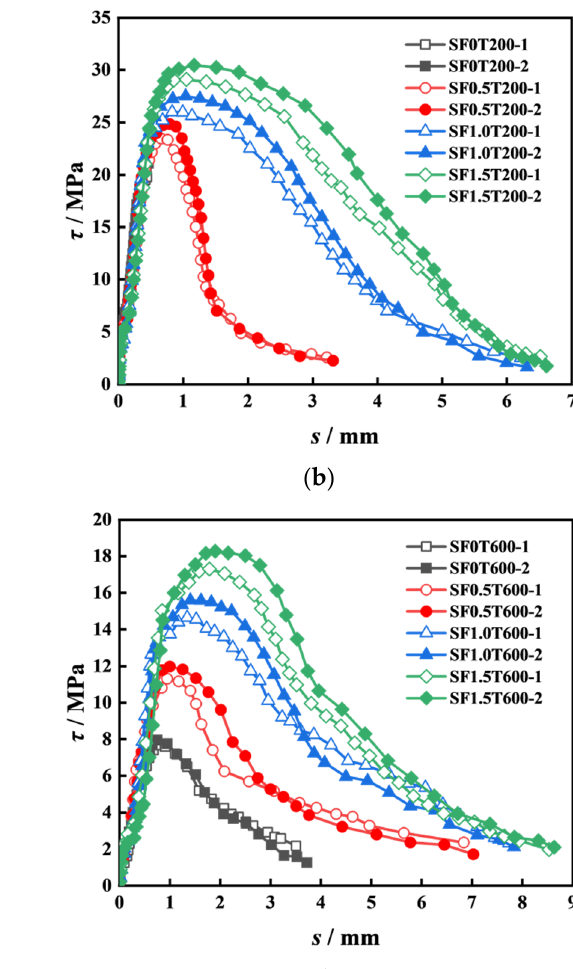
Figure 8. Bond–slip curves of specimens at ( a ) 20 °C, ( b ) 200 °C, ( c ) 400 °C, and ( d ) 600 °C.